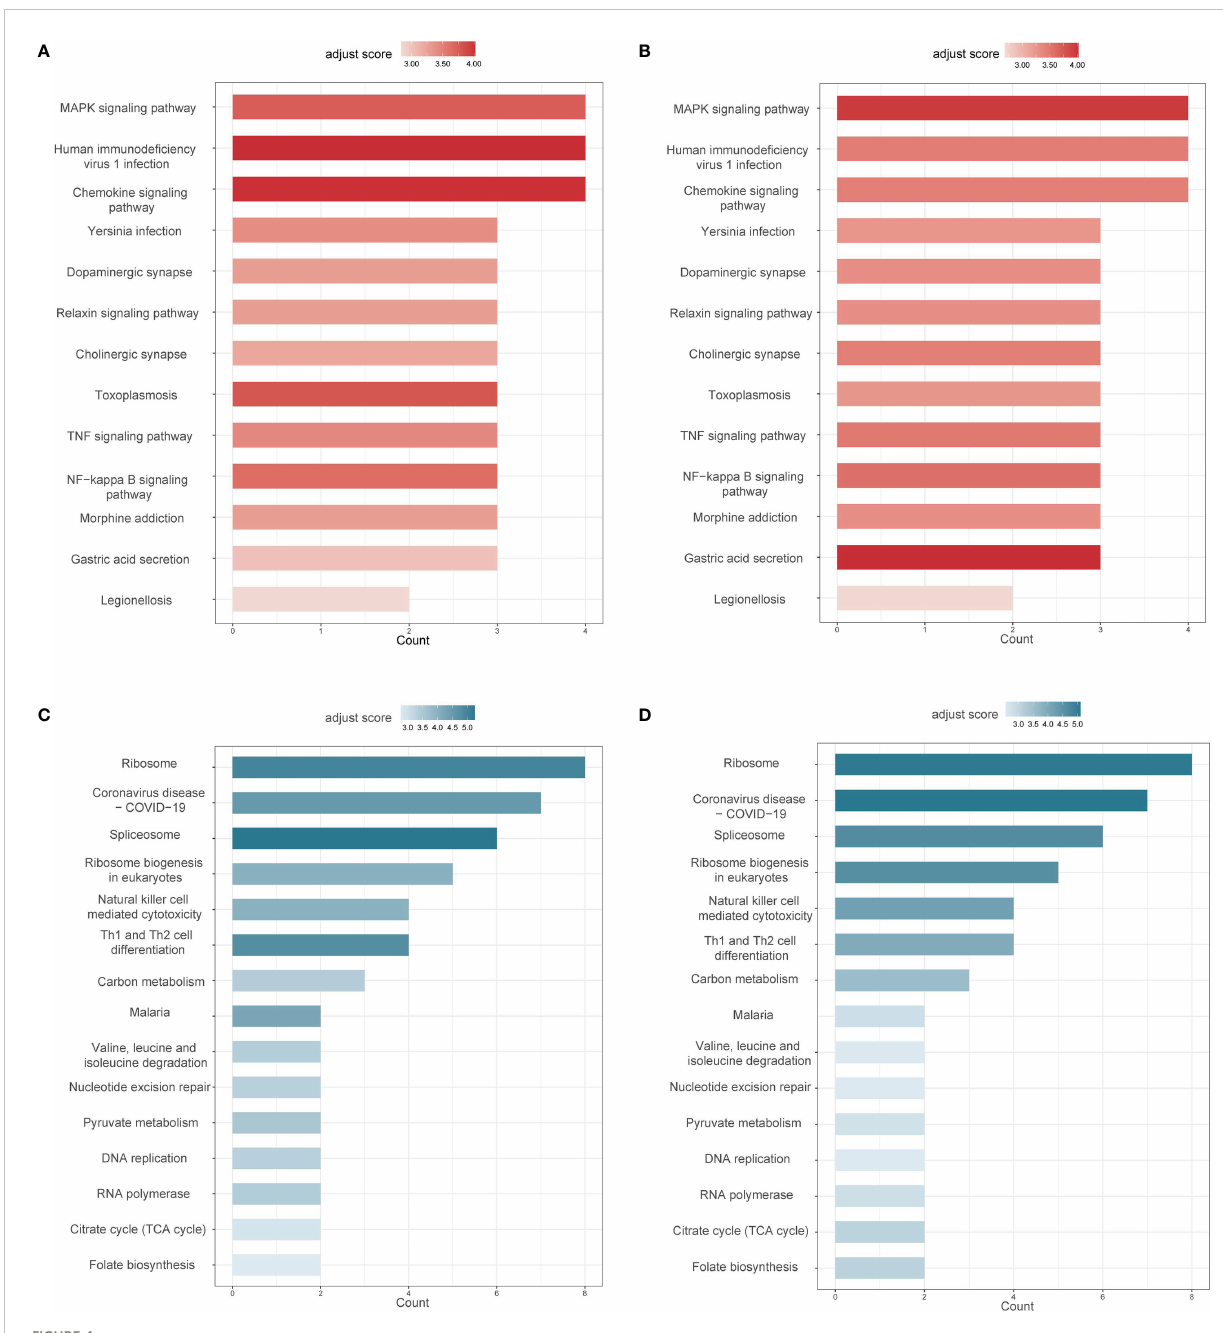
FIGURE 4 Common differential pathways in AS and IBD (adjust score calculated based on inverse cumulative distribution function) (A) Up-regulated differential pathways in AS. (B) Up-regulated differential pathways in IBD. (C) Down-regulated differential pathways in AS. (D) Down-regulated differential pathways in